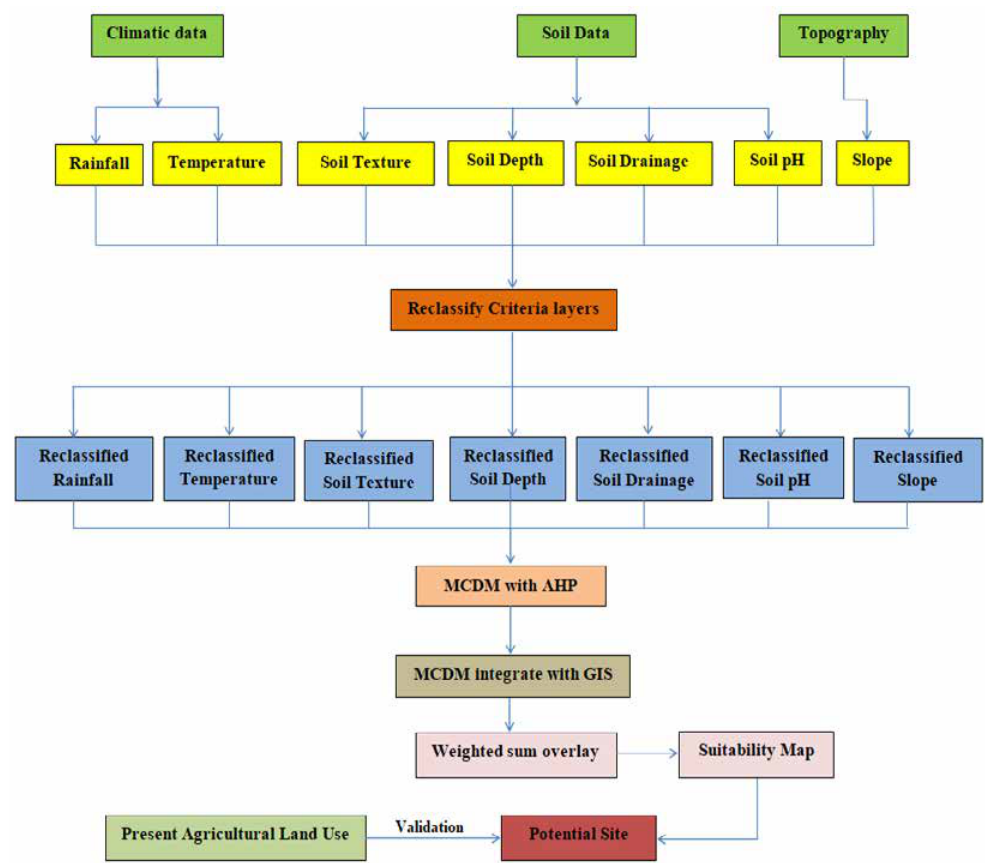
Fig. 2: Methodological approach for rice suitability mapping